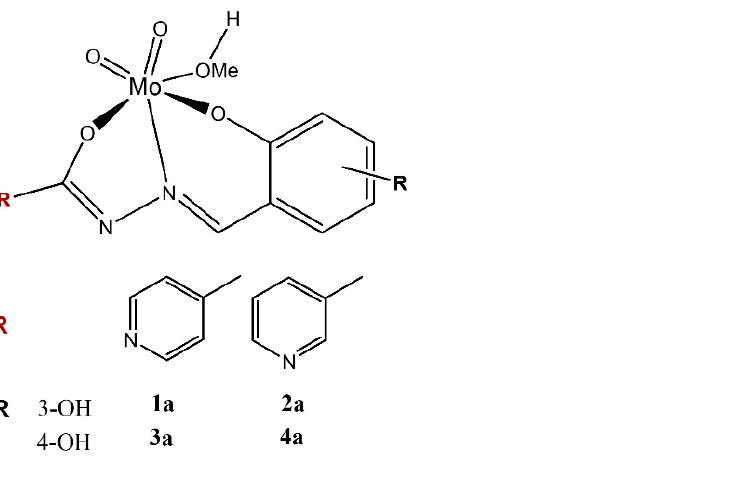
Scheme 1. The schematic presentation of the mononuclear [MoO 2 (L 1–4 )(MeOH)] complexes coordi- nated with hydrazonato ligands bearing hydroxyl group R , at position 3 or